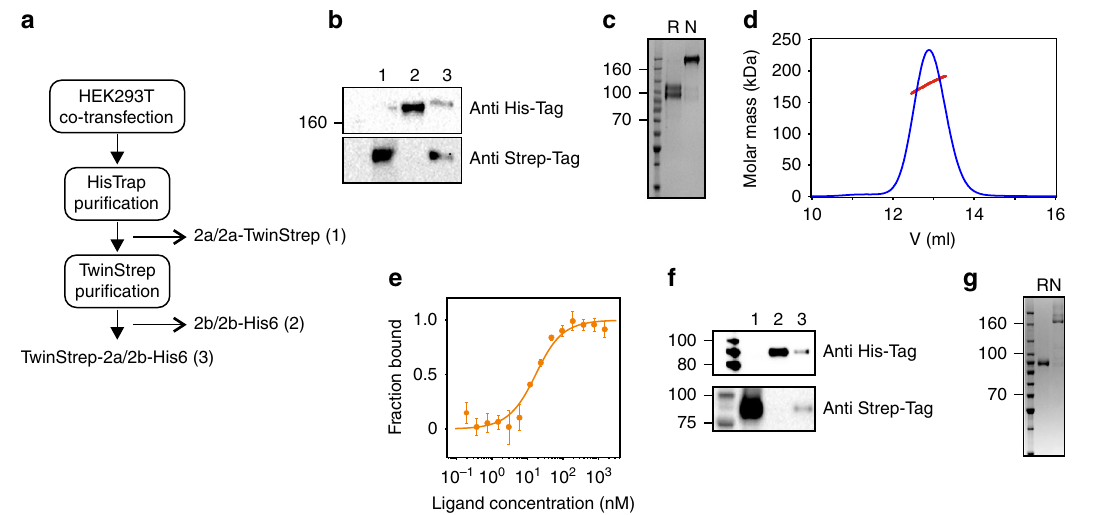
Fig. 5 Semaphorin heterodimerization. a HEK293T cells were transiently co-transfected with constructs encoding Sema2a-TwinStrep tag and Sema2b-His6 tag. Five days post transfection, the Sema2a/2b heterodimer was puri fi ed by two-step af fi nity chromatography on a HisTrap column followed by TwinStrep tag puri fi cation on a StrepTactin column. The unbound homodimers in fl ow-through, Sema2a/2a (1) or Sema2b/2b (2), and the puri fi ed Sema2a/2b heterodimer (3) were collected and used for western blot analysis. Similarly, for mouse Sema3A/3 C heterodimer, constructs encoding Sema3A-His6 tag and Sema3C-TwinStrep tag were used and the Sema3A/3C heterodimer was puri fi ed as the Drosophila Sema2a/2b heterodimer. b Western blot analysis (SDS-PAGE under non-reducing conditions) of the unbound homodimers in fl ow-through (1) and (2), and the puri fi ed Sema2a/2b heterodimer (3). c SDS- PAGE of the puri fi ed Sema2a/2b heterodimer under reducing and non-reducing conditions shows that Sema2a/2b is a disul fi de-linked heterodimer. d Size- exclusion chromatography with multi-angle light scattering of the Sema2a/2b heterodimer indicates an experimental protein mass of 156 ± 0.8 kDa, which is in agreement with the theoretical molar mass of 163 kDa. e Microscale thermophoresis binding experiment for PlexB 1 – 4 -mVenus and the Sema2a/2b heterodimer. Error bars represent s.d. of three technical replicates. f Western blot analysis (SDS-PAGE under reducing conditions) of the unbound homodimers in fl ow-through (1) and (2), and the puri fi ed Sema3A/3 C heterodimer (3). g SDS-PAGE of the puri fi ed Sema3A/3 C heterodimer under reducing and non-reducing conditions. Source data are provided as a Source Data fi